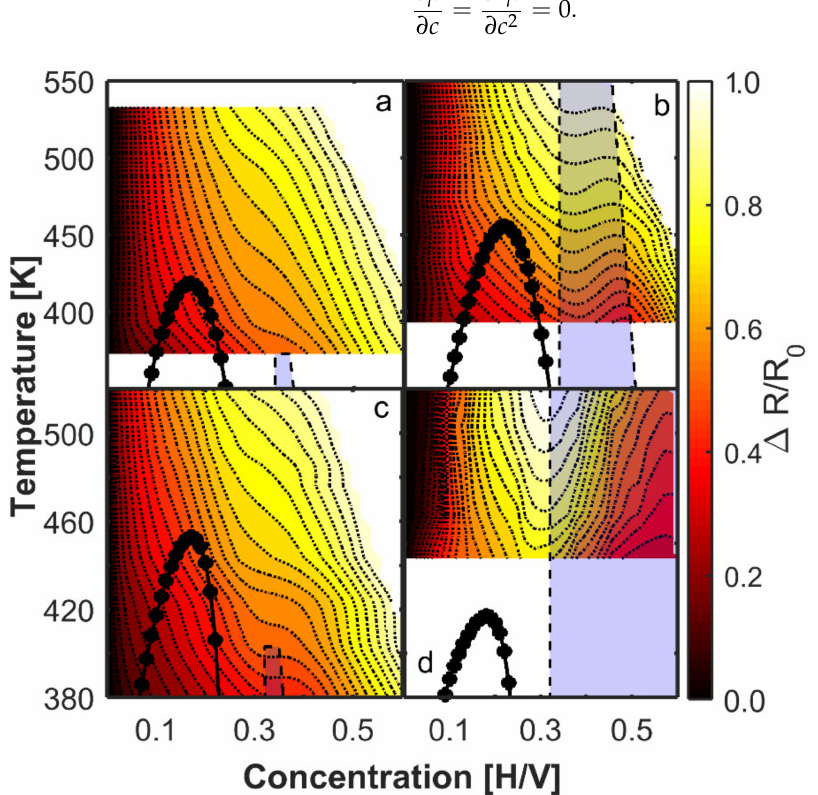
Figure 4. Phase diagram for the Cr 2 /V 14 superlattice, Cr 3 /V 21 superlattice, Fe 3 /V 21 superlattice and 50 nm V film, which correspond to the panels of ( a – d ), respectively. The color contour symbolizes the changes in excess resistivity. The bright blue areas indicate an ordered phase based on the resistivity changes. The Fe 3 /V 21 superlattice resistivity data was measured in previous study but not published yet [5]. The spinodal temperatures are shown as the insert in the figures (black